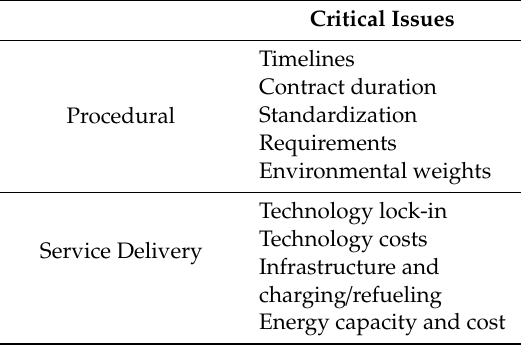
Table 3. Critical issues for successful green public procurement in maritime passenger